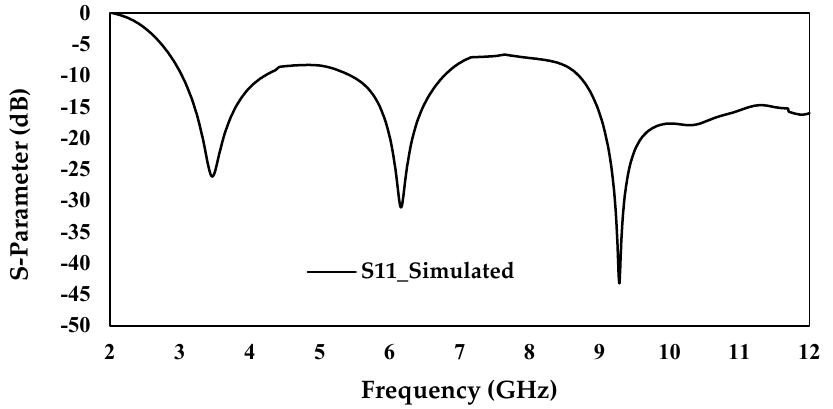
Figure 6. Simulated reflection coefficient curve of the proposed triple-band UWB antenna with dual-notch.